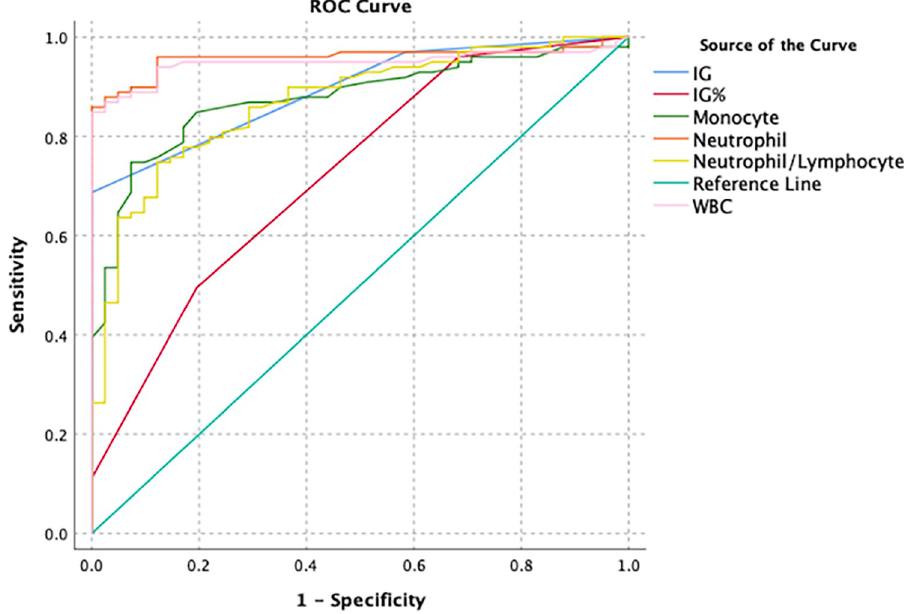
Fig 1. ROC analysis of haematological parameters in the diagnosis of acute appendicitis patients.